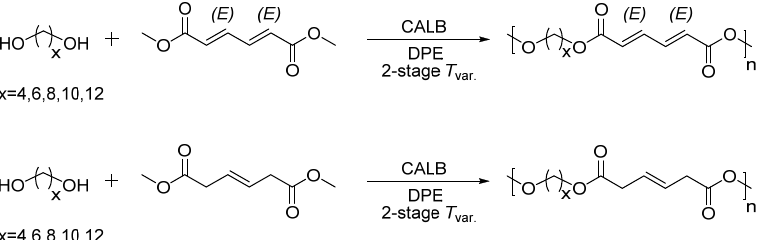
Scheme 2. The polymerization reaction of unsaturated diesters ( tt MUC and TBHM) with diols (with various methylene numbers between 4 and 12).